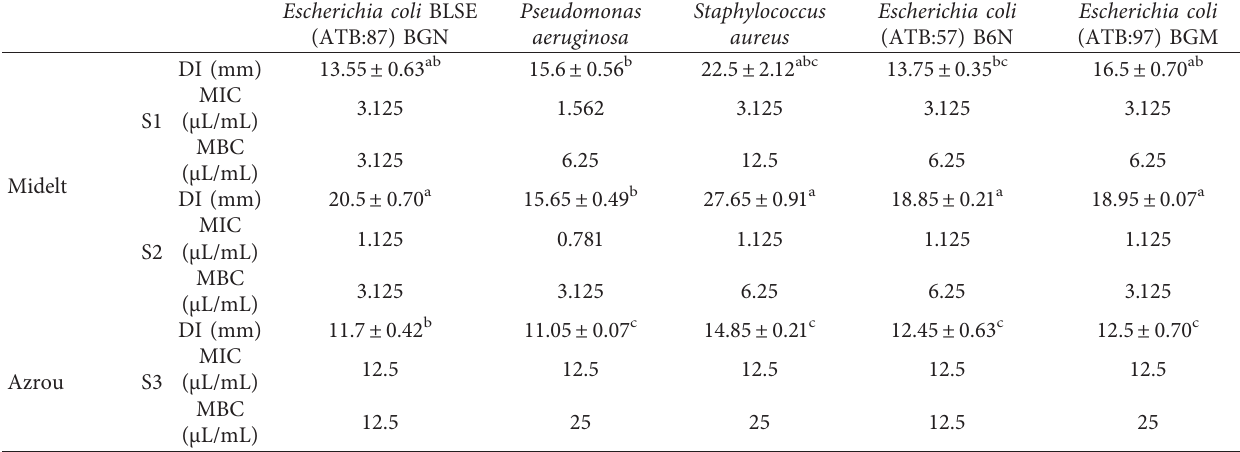
Table 5: Diameters of inhibition zones (DI) and MICs and MBCs values of vinegar samples generated against different bacterial